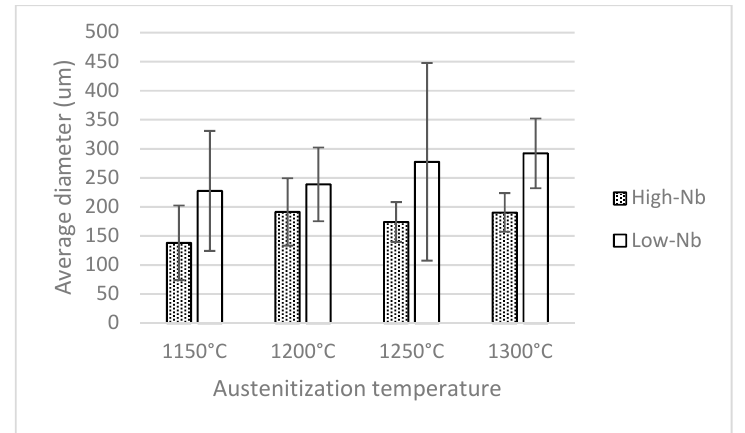
Figure 10. Average Feret diameter of Prior-Austenitic Grains. Measured from light microscopy after picral etching.